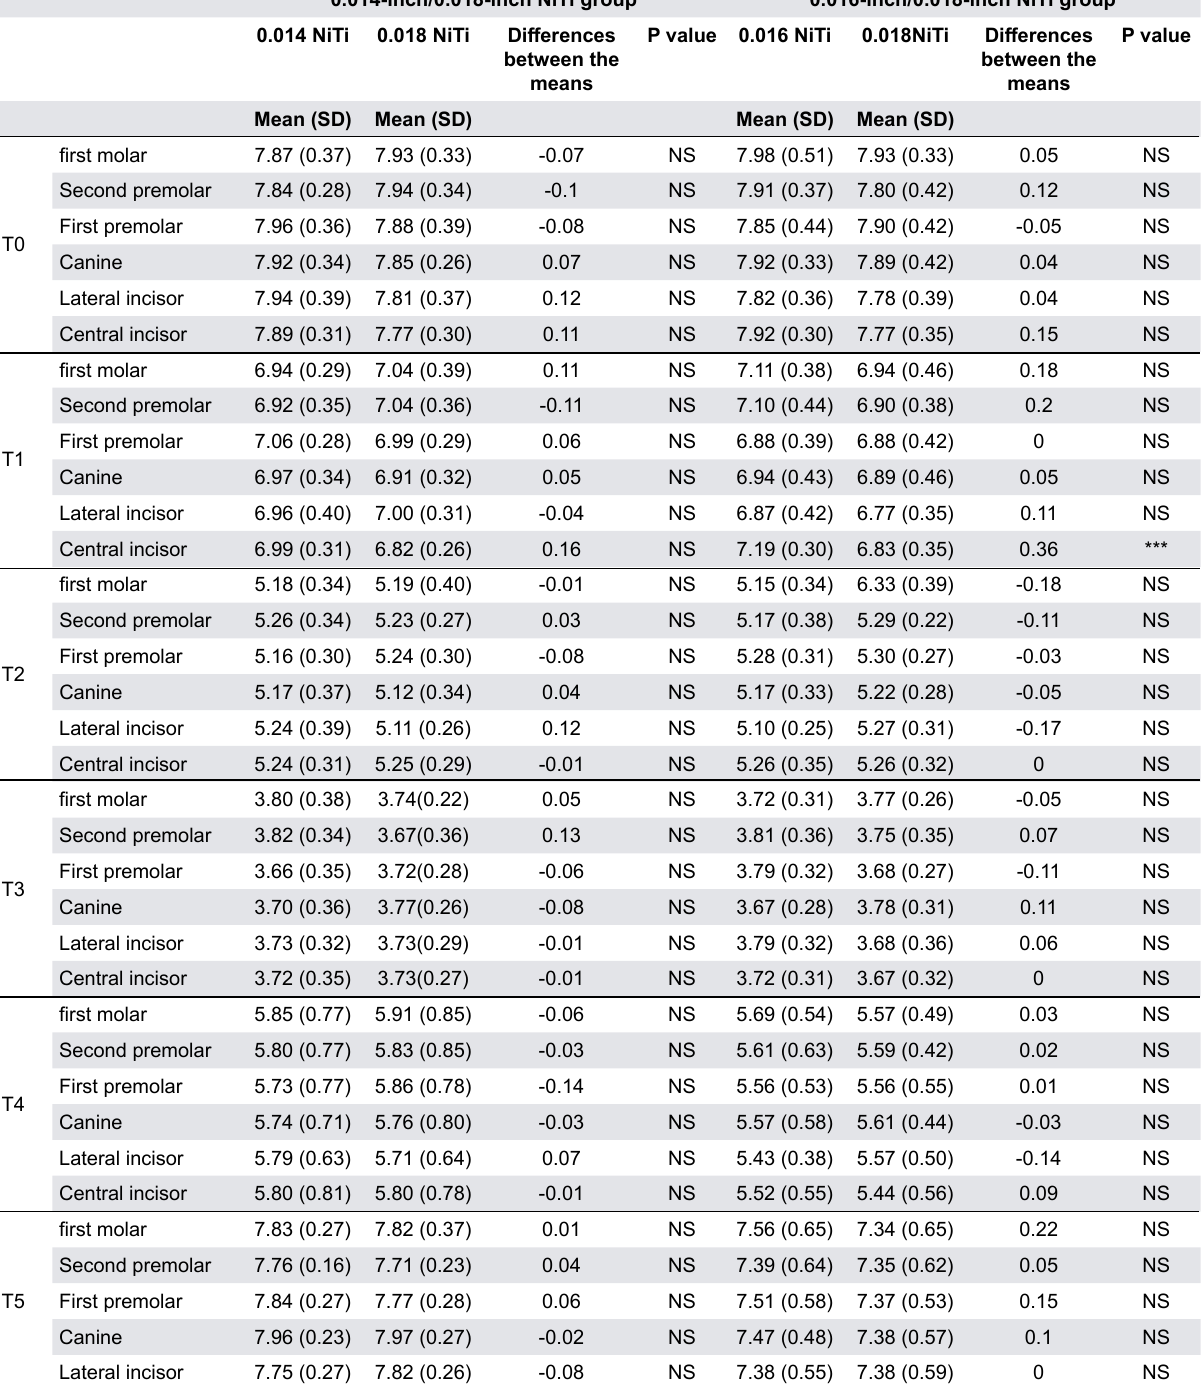
Table 5- Means, SD, diff. between the means of the two studied groups and p-values for PBF from baseline (T0) to (T5) for each measured